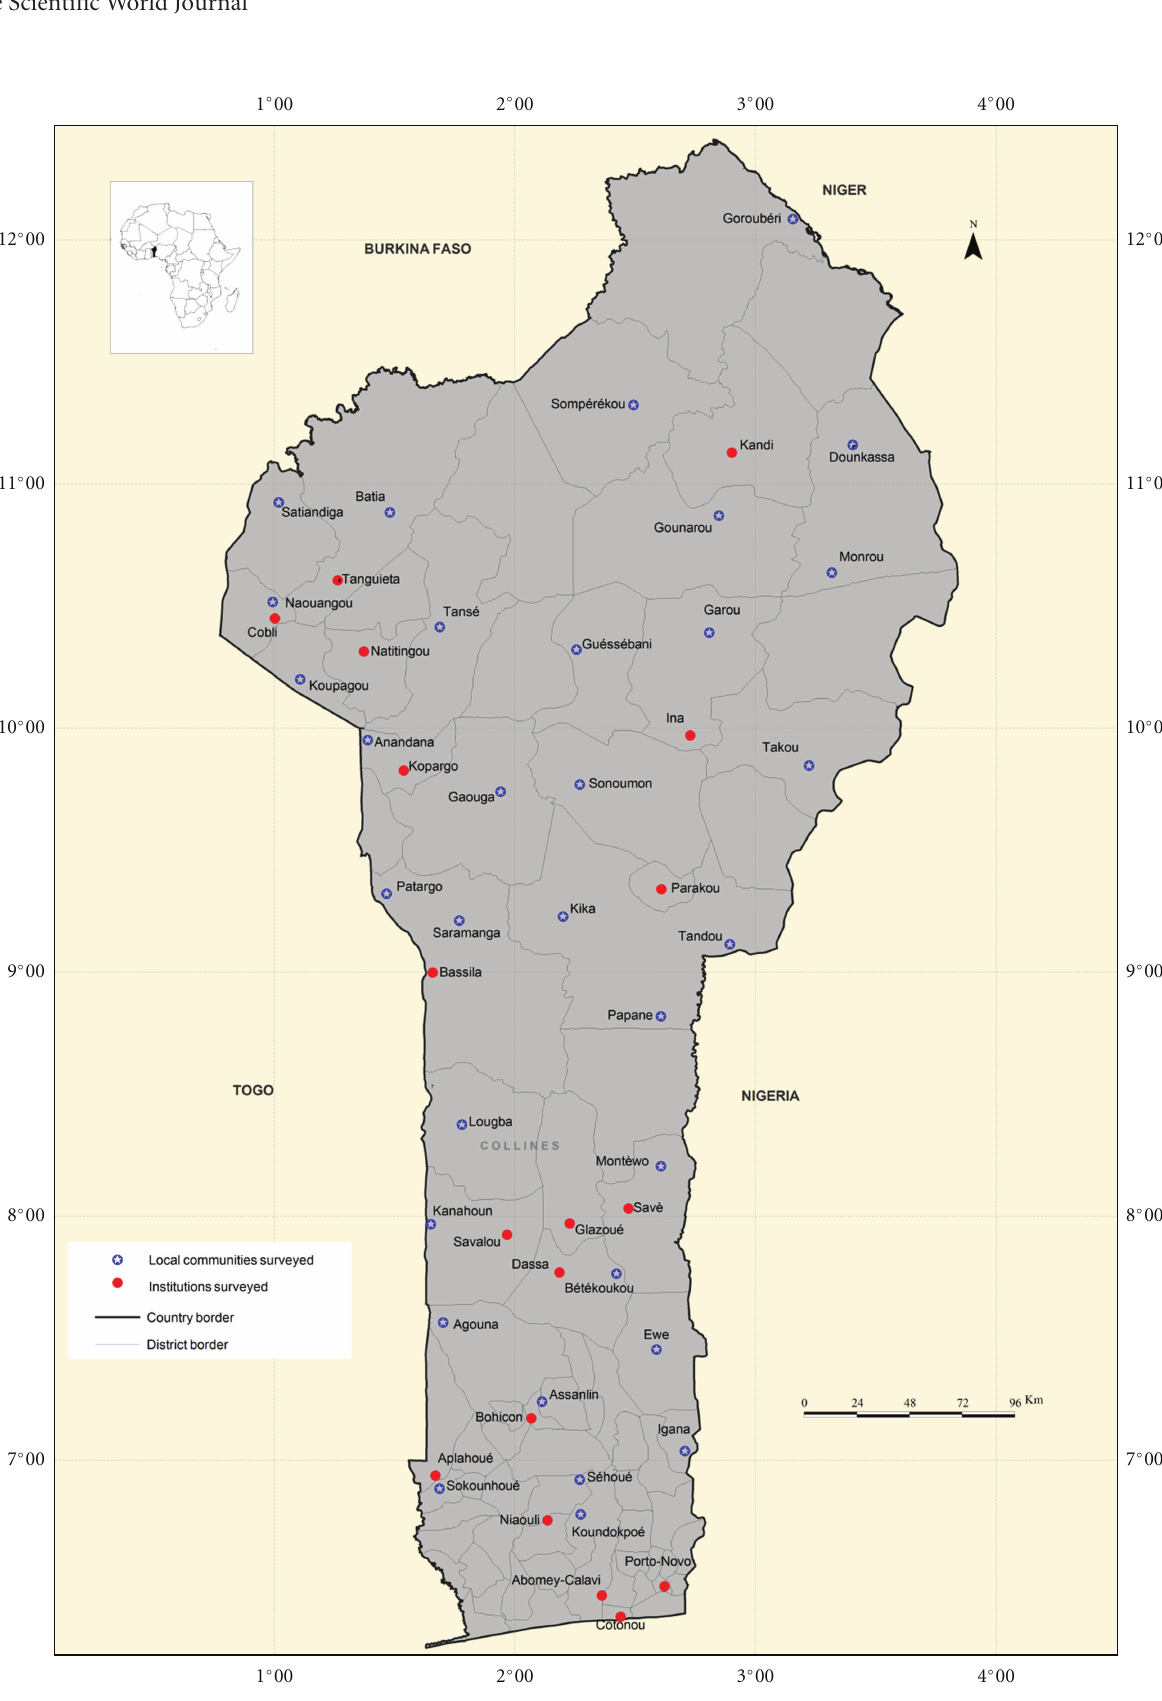
Figure 1: Benin map showing the geographical location of the villages and institutions